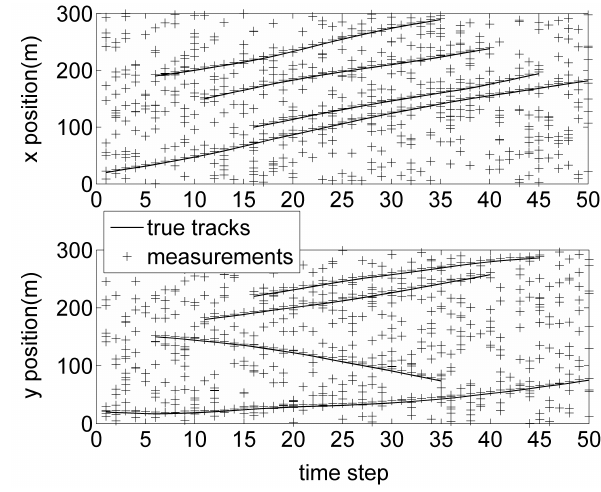
Figure 1. True target tracks and measurements.